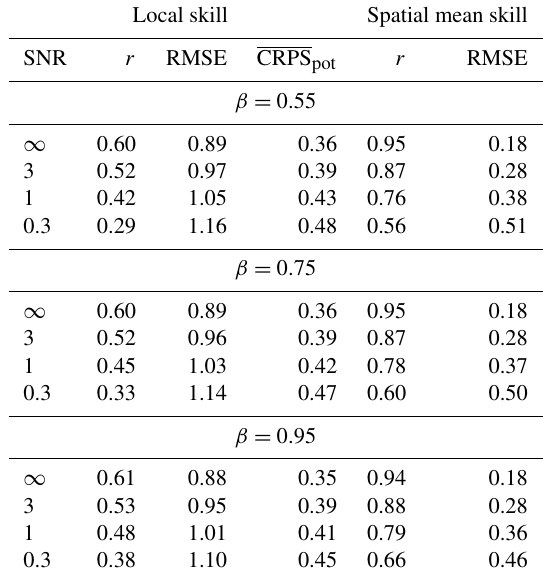
Table 4. Median local skill measurements Local skill Spatial mean